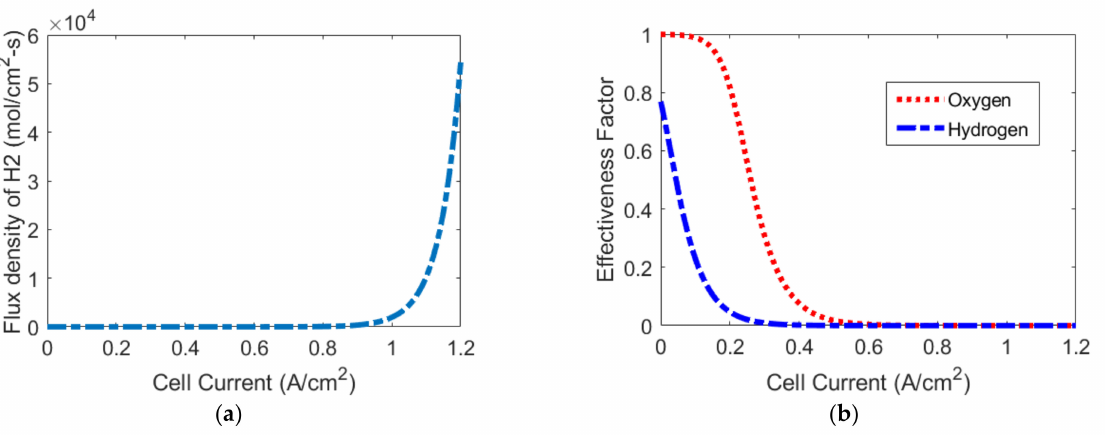
Figure 14. Simulated CL behavior as a function of current density: ( a ) surface-specific flux of H 2 ; ( b ) effectiveness factors on the cathode and anode